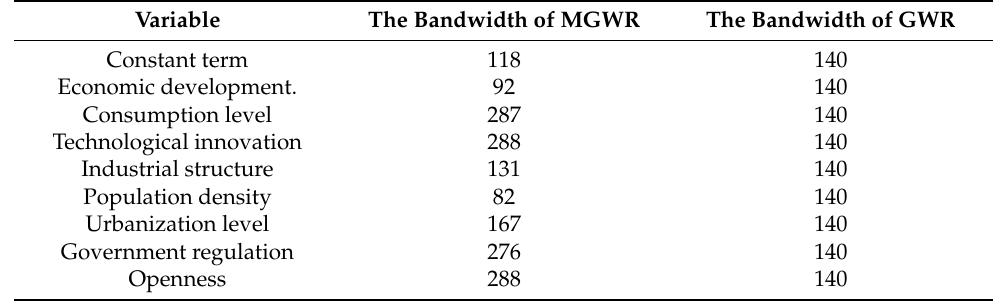
Table 4. GWR and MGWR bandwidth comparison.